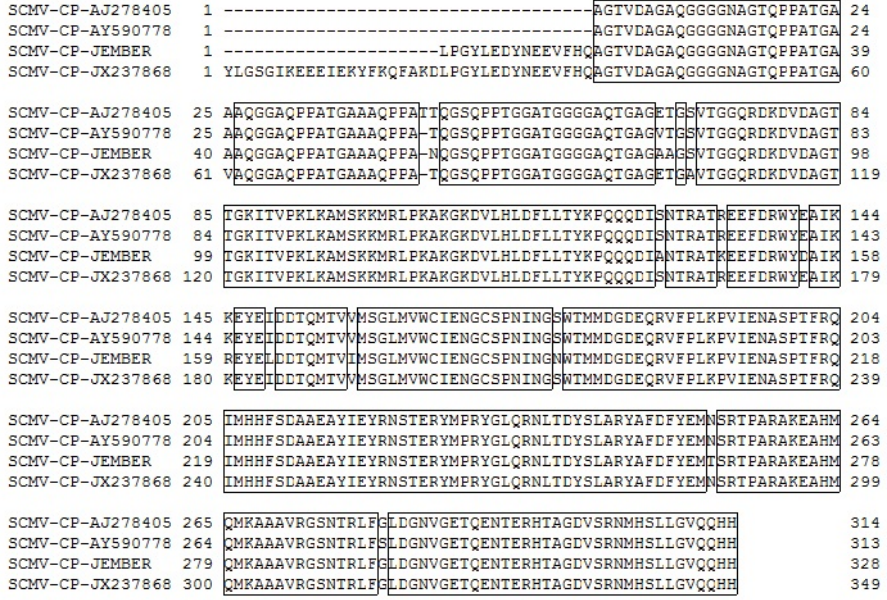
Figure 1. Multiple alignment at amino acid sequences of the SCMV coat proteins isolates from Australia (AJ278405.1), Argentina (JX237868.1), and China (AY590778.1), with isolate from PS881-Jember. Identical amino acid residues with isolate of Jember are indicated by boxed sequences. The three amino acids of DAG at N-terminal were used as initial amino acids for the synthesis of the recombinant coat protein.